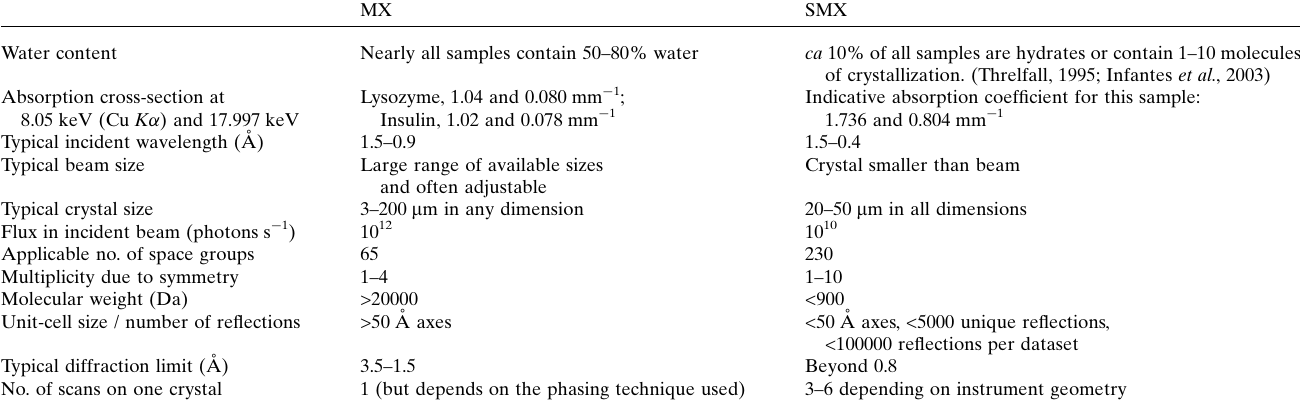
Table 1 Indicative values for some experimental characteristics that are significantly different between MX and SMX where sample-decay effects might thus be expected to be markedly dissimilar.